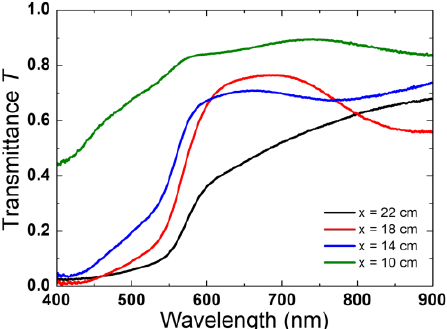
Figure 5. Optical transmittance of hematite films grown by CVD on FTO substrates. The spectra correspond to samples prepared at the positions of 10, 14, 18, and 22 cm.